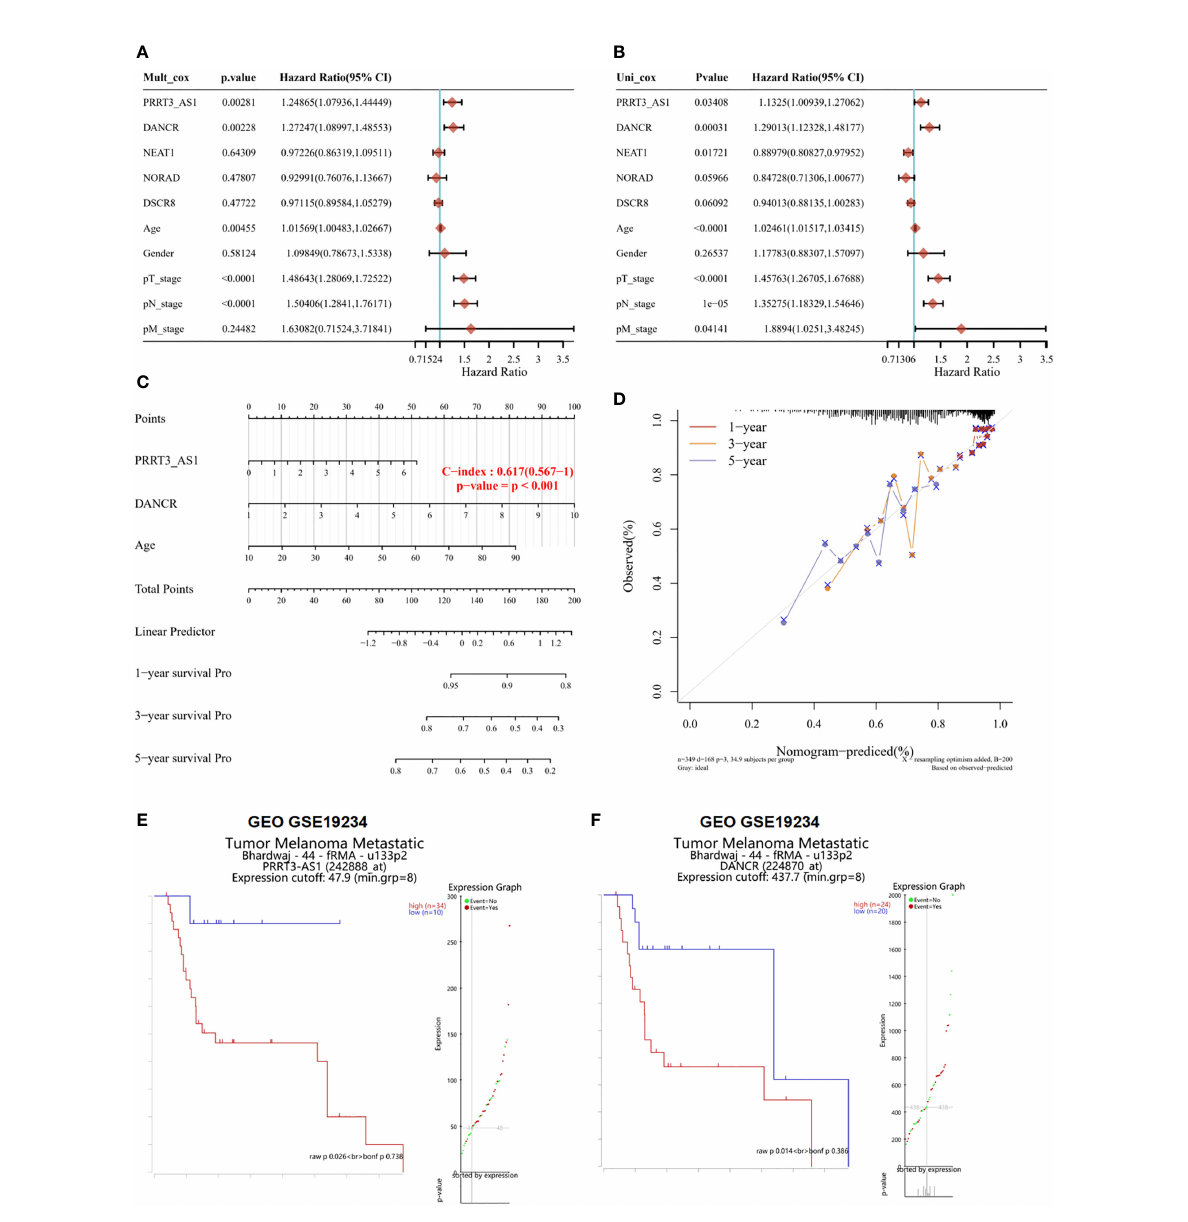
FIGURE 2 The identi fi cation of independent prognostic factors for OS and the development of the nomogram in TCGA-SKCM. Survival analysis of selected lncRNAs in the GEO dataset. Forest plot presenting the multivariate Cox regression analysis (A) and univariate Cox regression analysis (B) of selected lncRNAs. Nomogram (C) and the calibration curves (D) for predicting 1-, 3-, and 5-year overall survival of PRRT3-AS1 and DANCR. Overall survival curves and patient status according to the expression of PRRT3-AS1 (E) and DANCR (F)